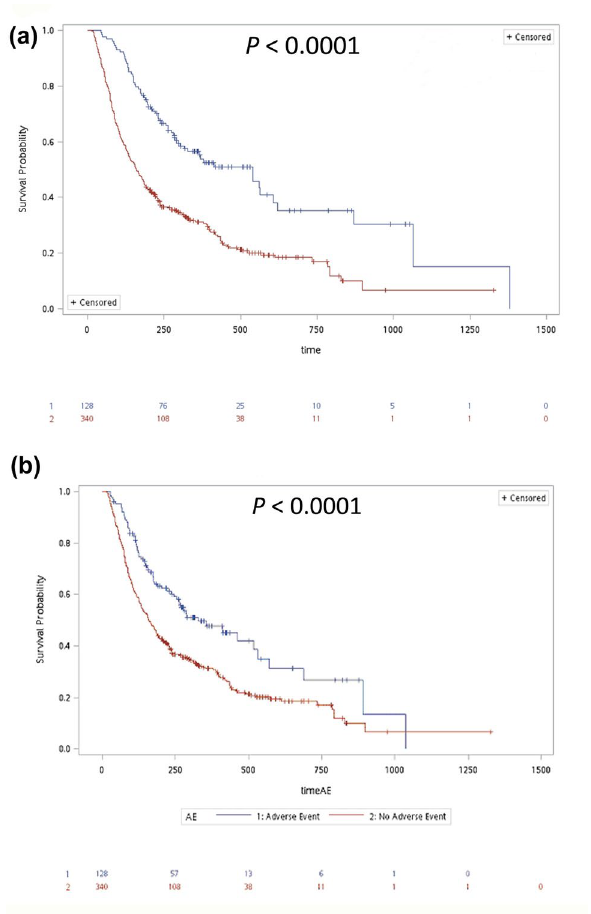
Figure 4. Patients with cutaneous irAEs had more survival benefits than those without cutaneous irAEs. ( a ) The Kaplan–Meier plot and log-rank test demonstrated that patients who suffered from cutaneous irAEs lived longer than those who did not. ( b ) Using the conditional landmark analysis, patients with cutaneous irAEs showed a longer survival time than those without cutaneous irAEs.